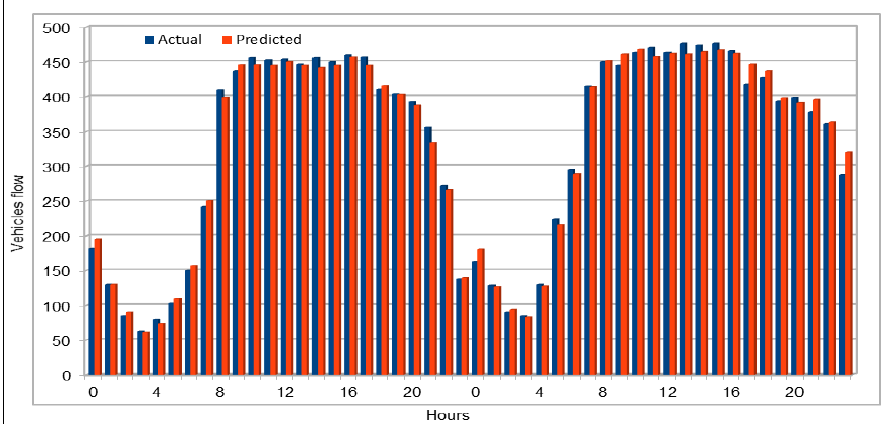
Figure 6. Traffic flow: Actual and predicted values (average of all VDS) (48 h).